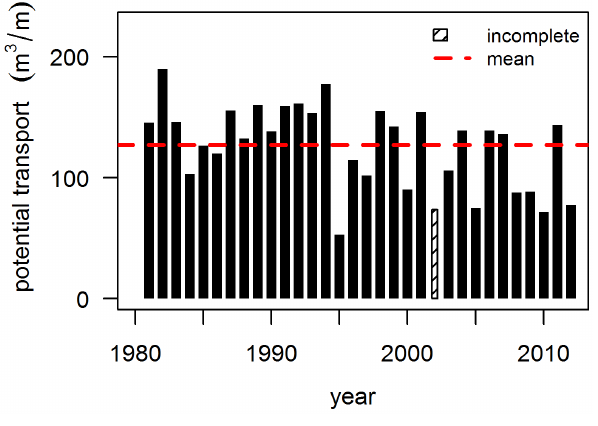
Figure 5. Yearly transport potential. Yearly transport potential for location Noord-Holland. The measurements of 2002 are incomplete, with 22 hours of missing data. This hiatus seems unrelated to storm conditions. The mean transport potential is 125 m 3 /m.